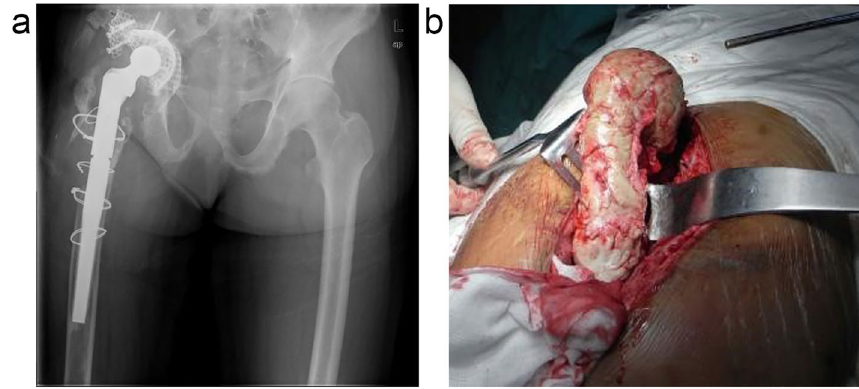
Fig. 3 A PJI case with a modular femoral stem. The femoral stem was firmly fixed and difficult to remove. After the removal of the proximal component, a spacer was placed. Pre- ( a ) and intraoperative ( b ) images are